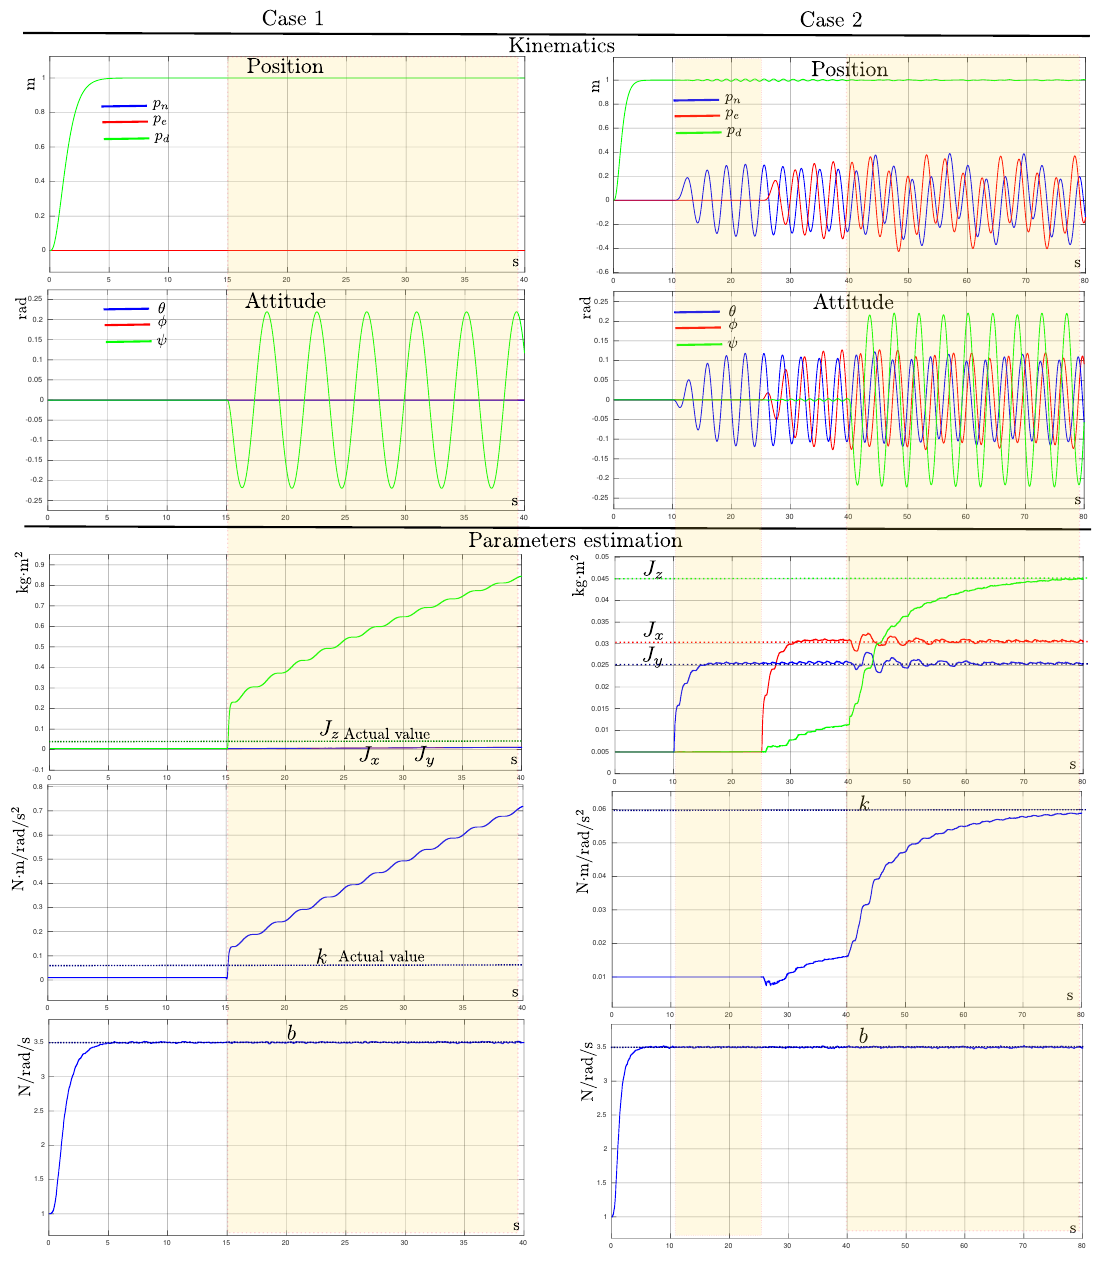
Figure 6. Parameter estimates obtained from different observability conditions. The left and right plots show respectively the results obtained in the Case 1 and Case 2 tests. The upper plots show the maneuvers of the aerial vehicle carried out to establish the different observability conditions. The lower plots show the parameter